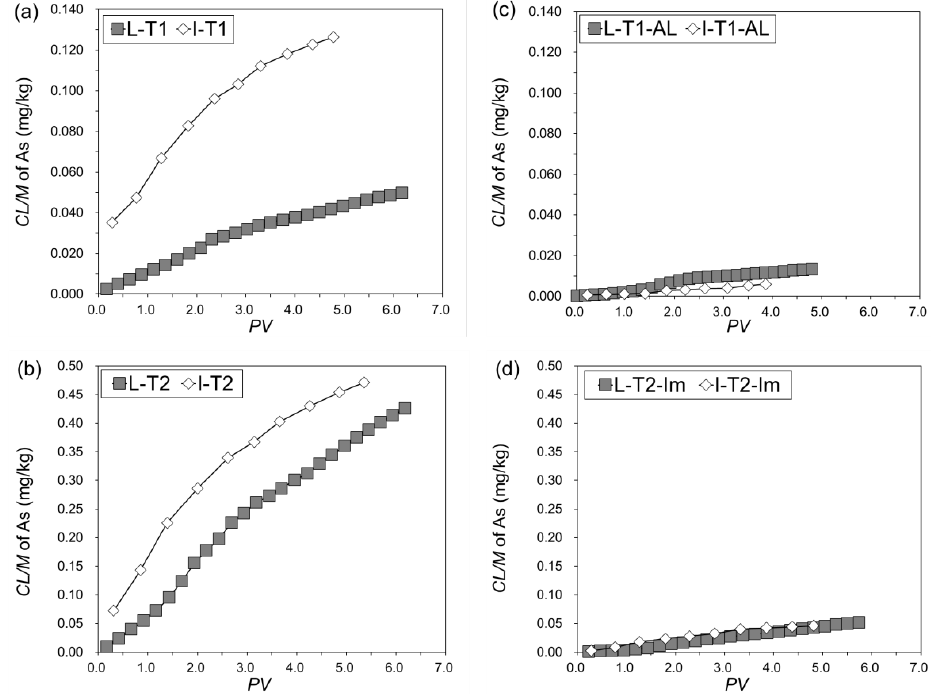
Figure 4. Changes in CL/M of As with PV ; ( a ) comparison between L-T1 and I-T1, ( b ) comparison between L-T2 and I-T2, ( c ) comparison between L-T1-AL and I-T1-AL and ( d ) comparison between L-T2-Im and I-T2-Im.